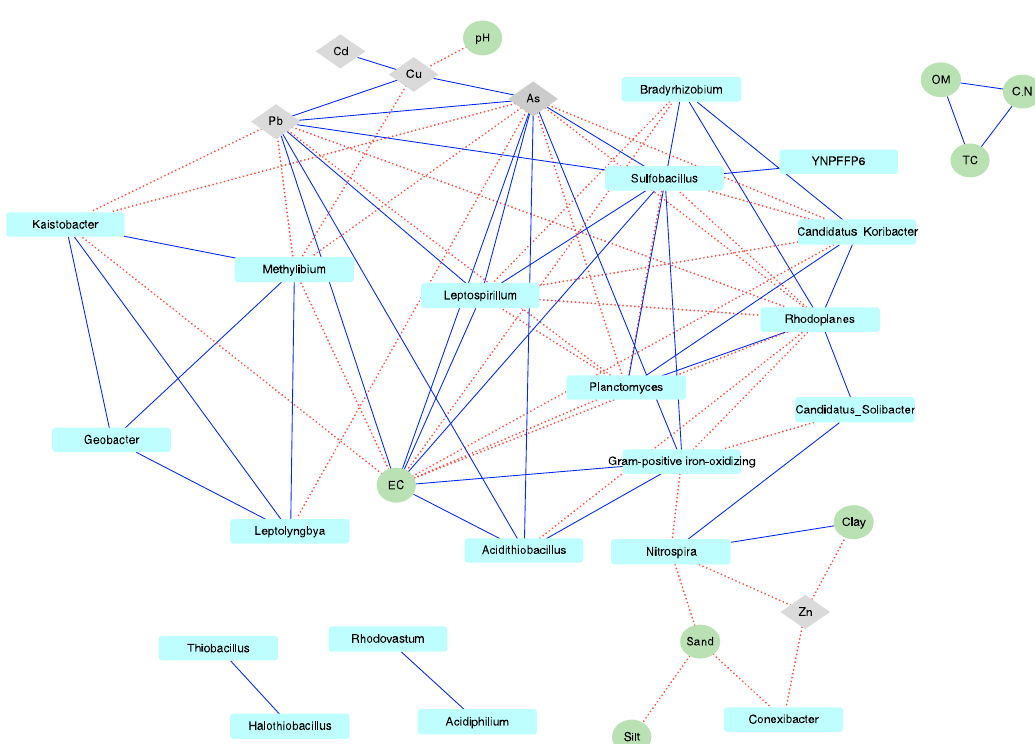
Figure 3. Profile clustering Cytoscape network visualization of the 32 most abundant genera with environmental correlation (solid line, positive correlation; dotted line, negative correlation) estimated by Spearman’s rank analysis. Analyzed genus, heavy metals, and other environmental factors are marked with cyan squares, gray diamonds, and green circles, respectively.